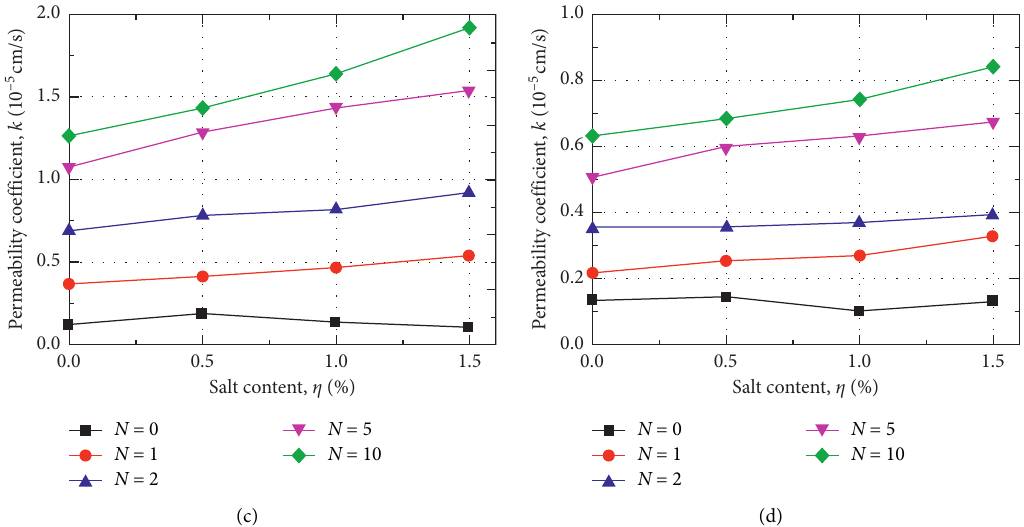
Figure 5: Permeability coefficient of saline intact loess at various salt contents. (a) σ